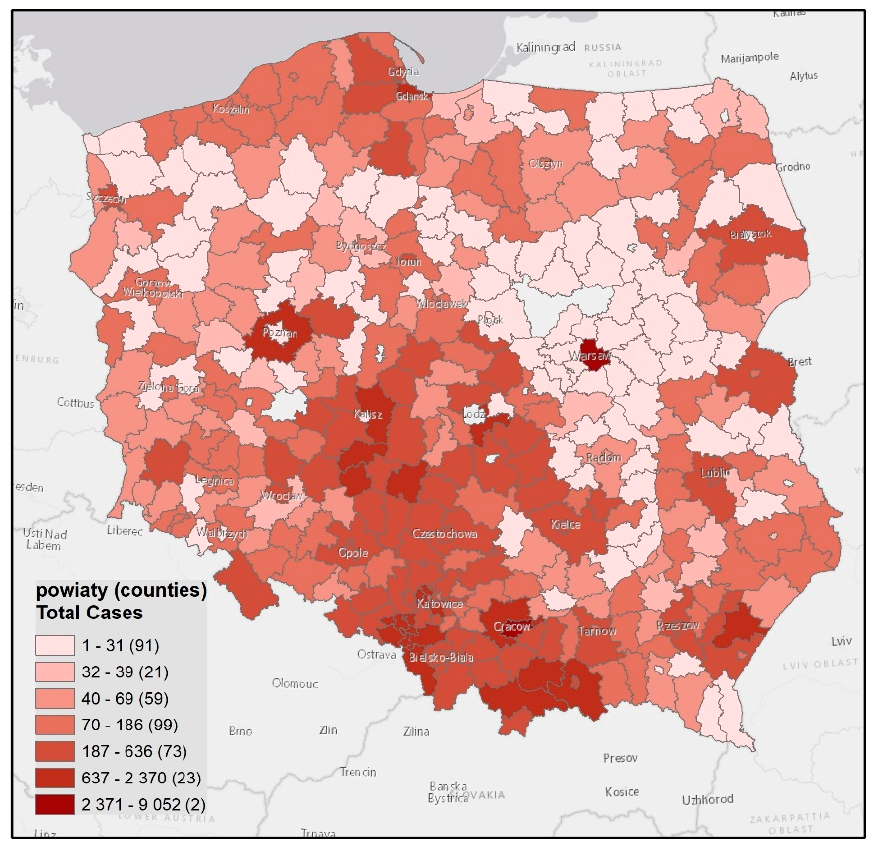
Figure 2. Total number of infections by county in Poland (from weeks 11 to 42 of 2020); our study was based on data from the Ministry of Health, Poland.